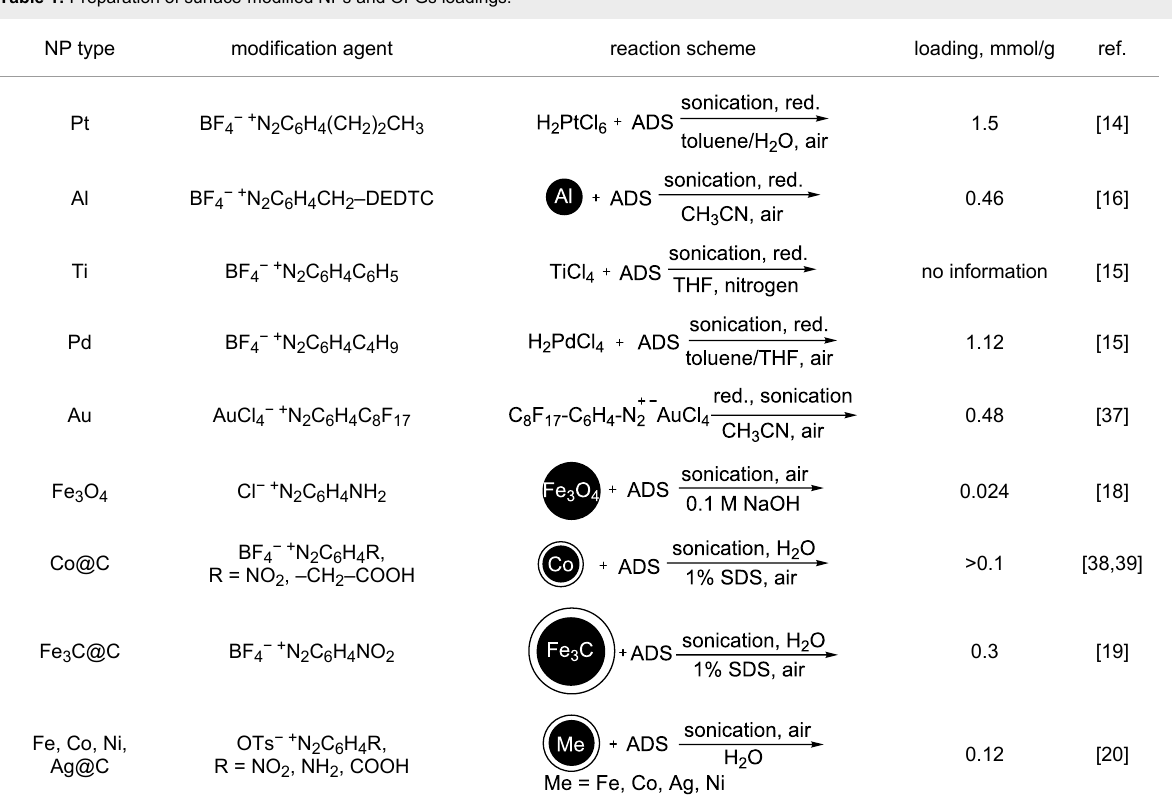
Table 1: Preparation of surface-modified NPs and OFGs loadings. a